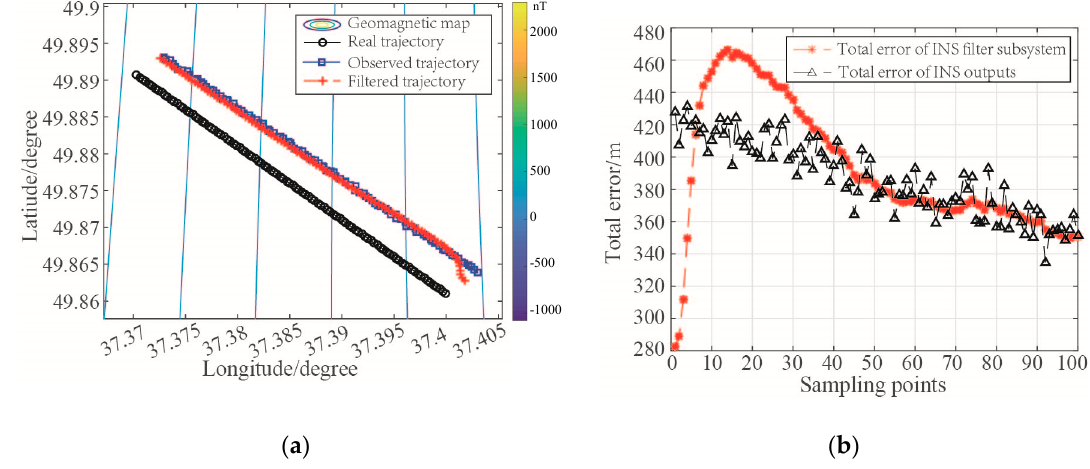
Figure 9. Filtering results of the INS filter subsystem: ( a ) Filtering trajectory of the INS filter subsystem; ( b ) Total location error of the INS filter subsystem.